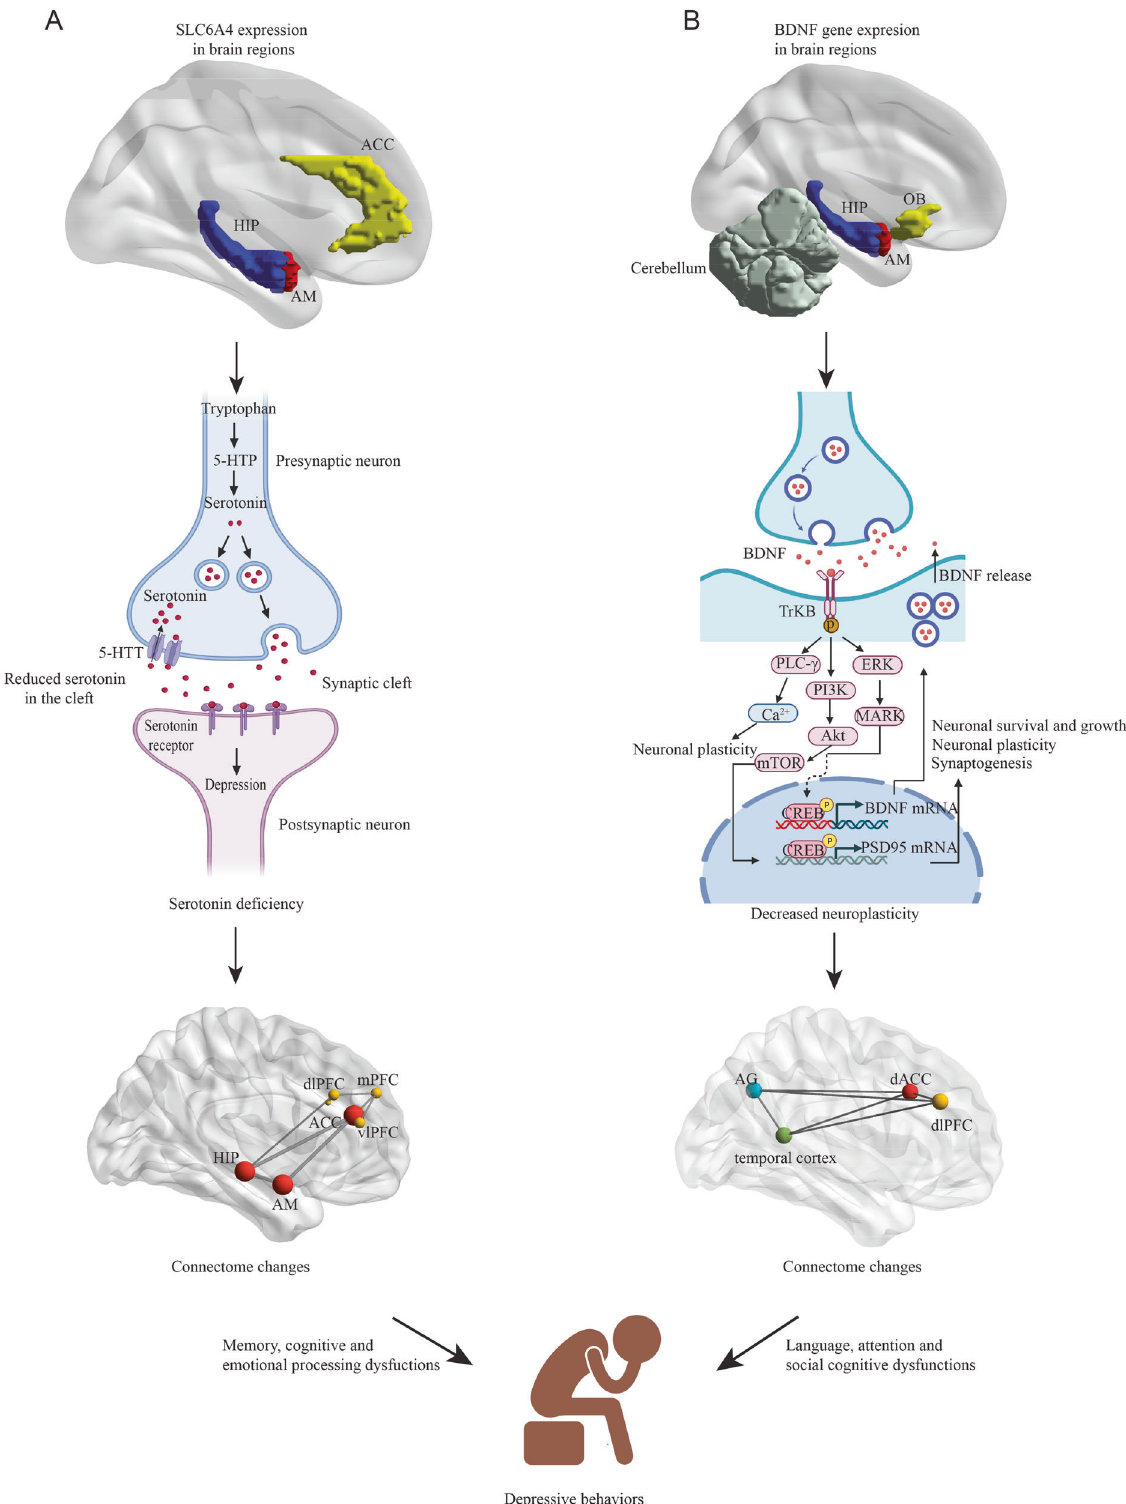
Fig. 2 The associations between gene expression, MDD pathogenesis, and fMRI-based brain functional connectome changes. ( A ): Serotonin de fi ciency hypothesis; ( B ): Neuroplasticity hypothesis. The gene expression mappings were created according to PET-MR data from Ref. [26], and RNA-seq data from Ref. [25]. The colored brain regions represent higher gene expression levels. The maps of brain functional connectome were manually created according to the data from Ref. [33]. HIP, Hippocampus; AM, Amygdala; ACC, Anterior cingulate cortex; OB: Olfactory bulb; BDNF, Brain-derived neurotrophic factor; 5-HTTP, 5-Hydroxytryptophan; 5-HTT, Serotonin transporter; mPFC, medial prefrontal cortex; AG, Angular gyrus; dACC, Dorsal anterior cingulate cortex; dlPFC, dorsolateral prefrontal